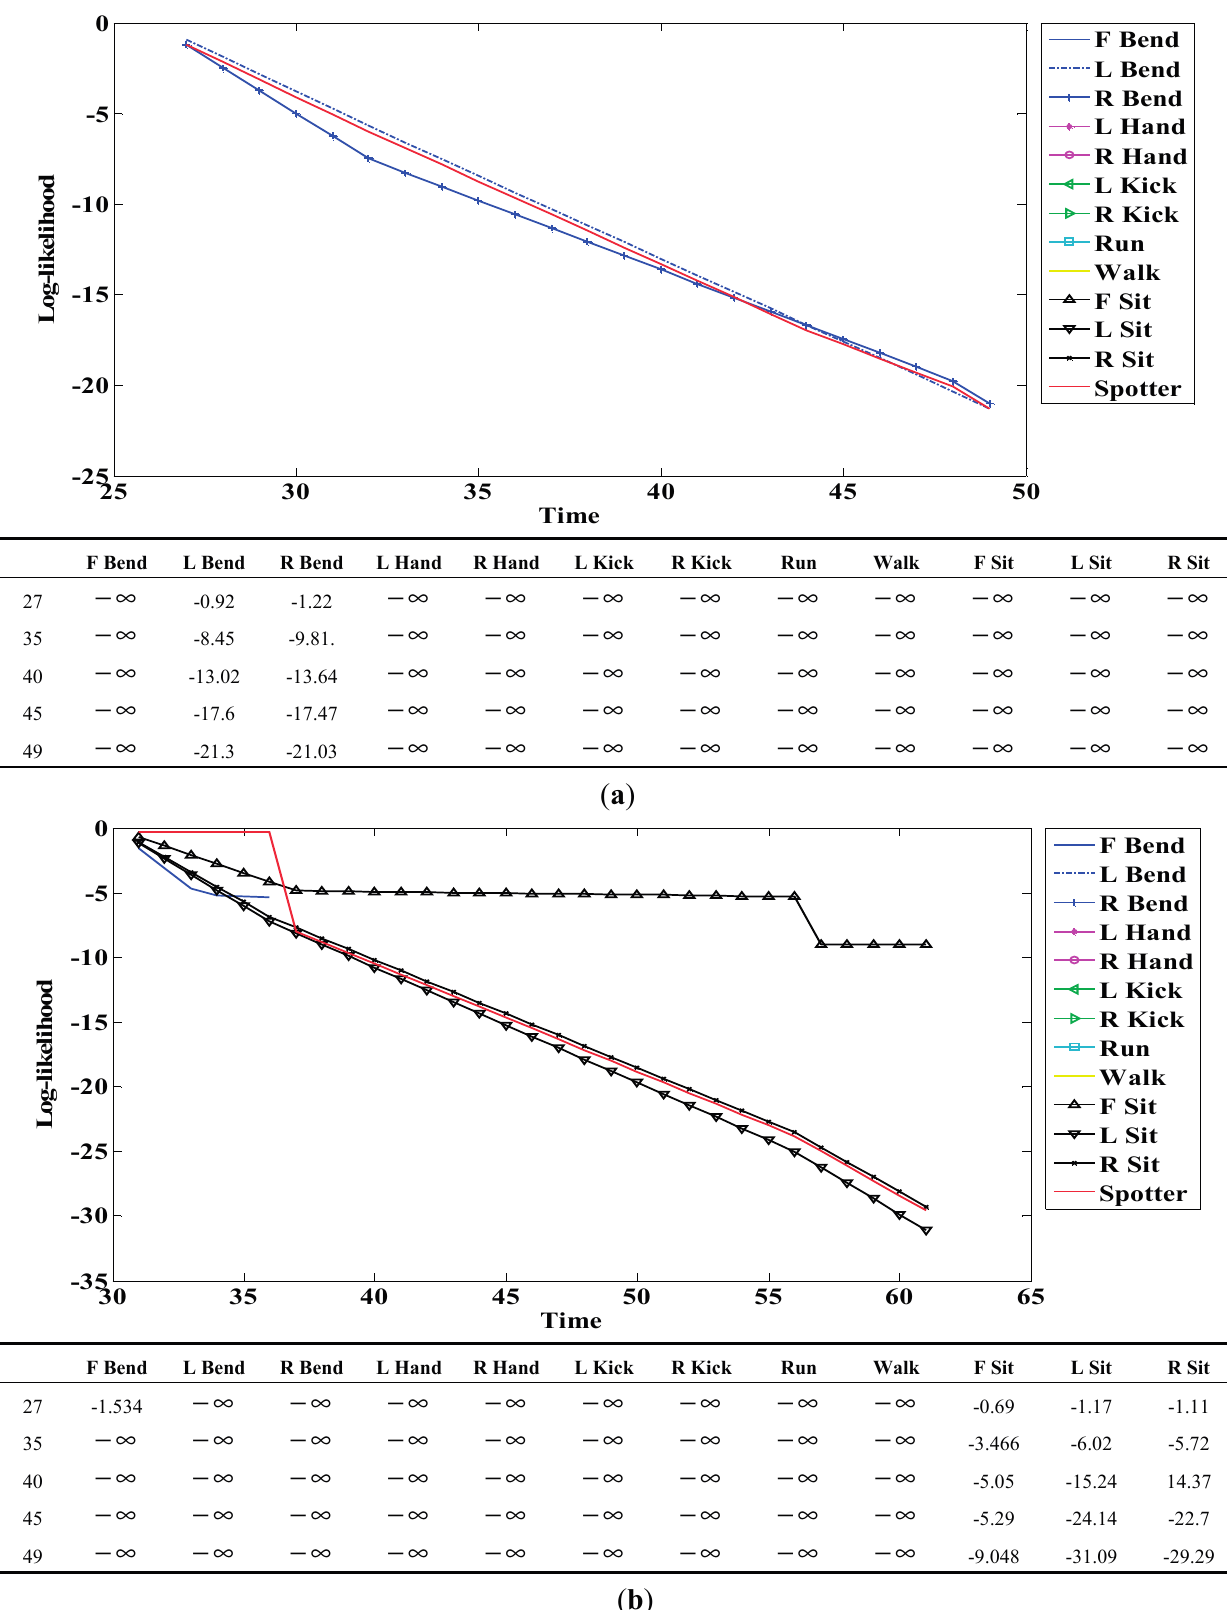
Figure 18. Example of log-likelihood for ( a ) R Bend; and ( b ) F